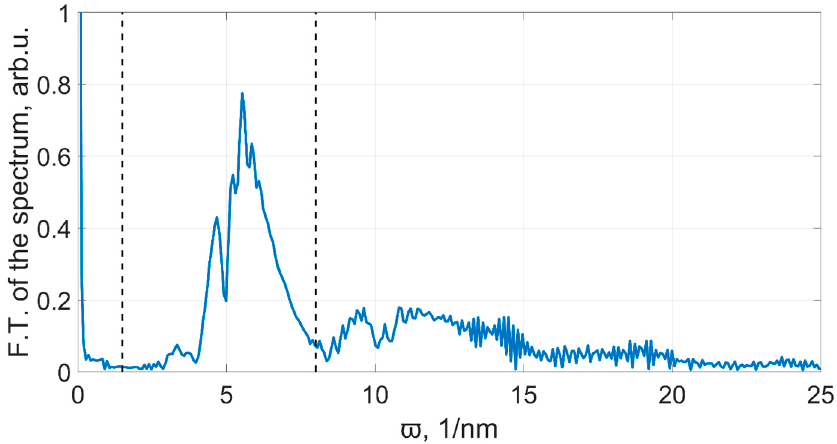
Figure 6. The Fourier transform of the sensor’s spectrum, presented in the generalized frequency space.